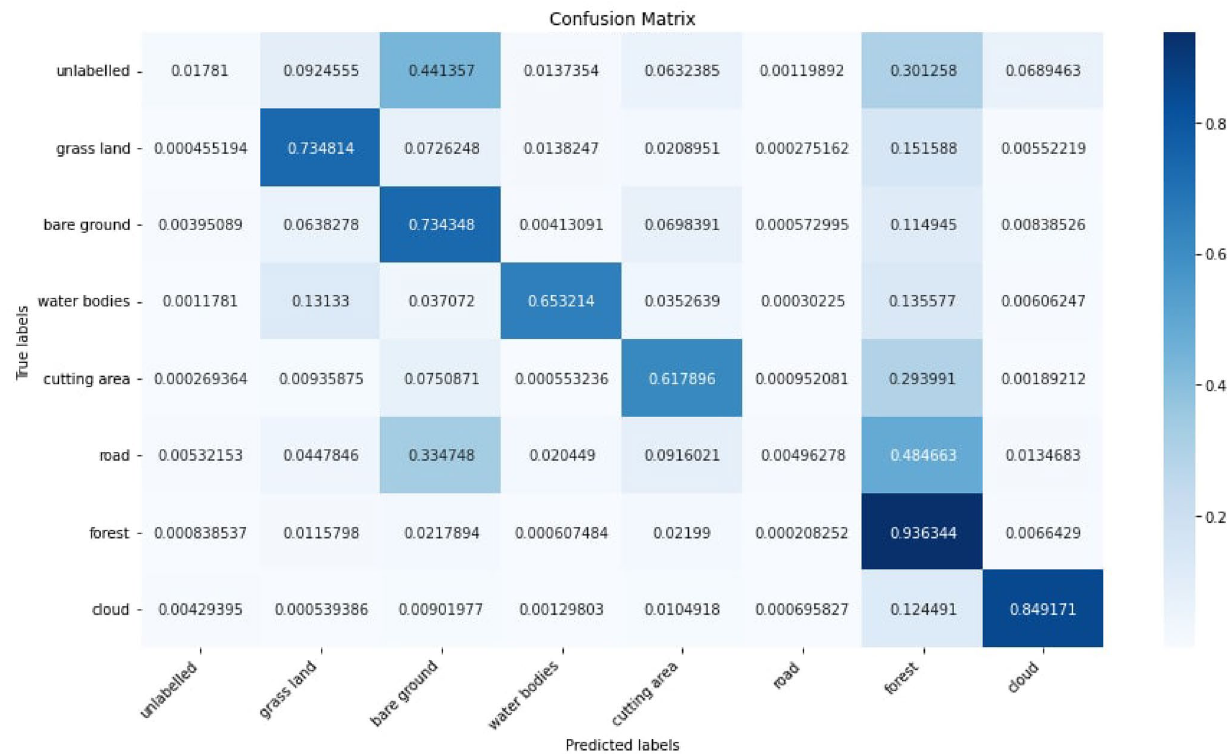
Fig. 6 Confusion matrix for LinkNet-ResNet34